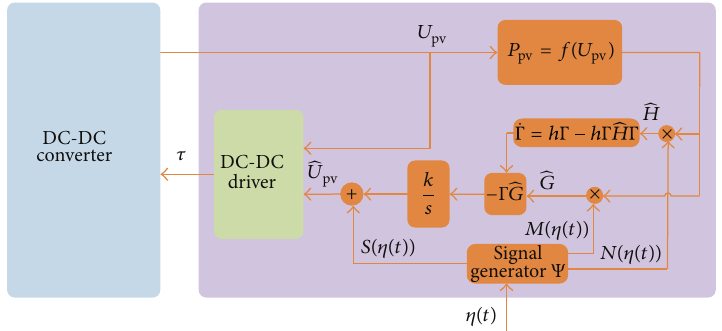
Figure 5: The structure of Newton-based extremum seeking MPPT controller.